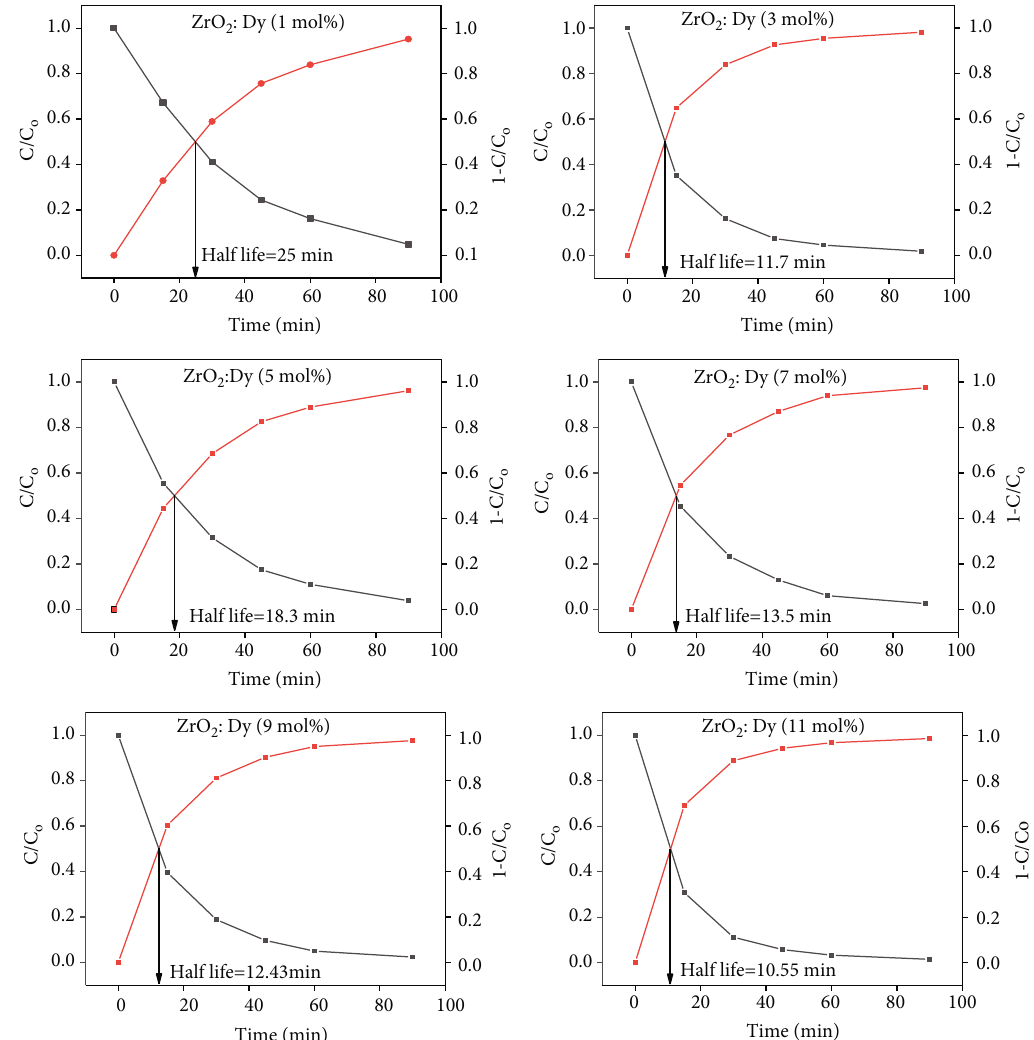
:Dy 3+ (1-11mol%) photocatalyst. 2